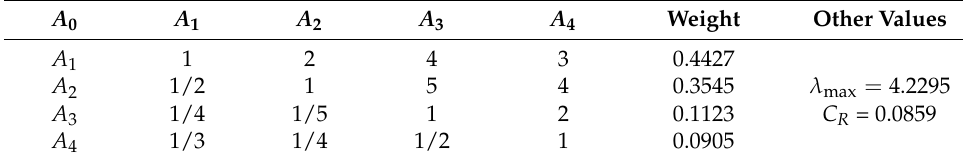
Table 7. Calculation results of primary index